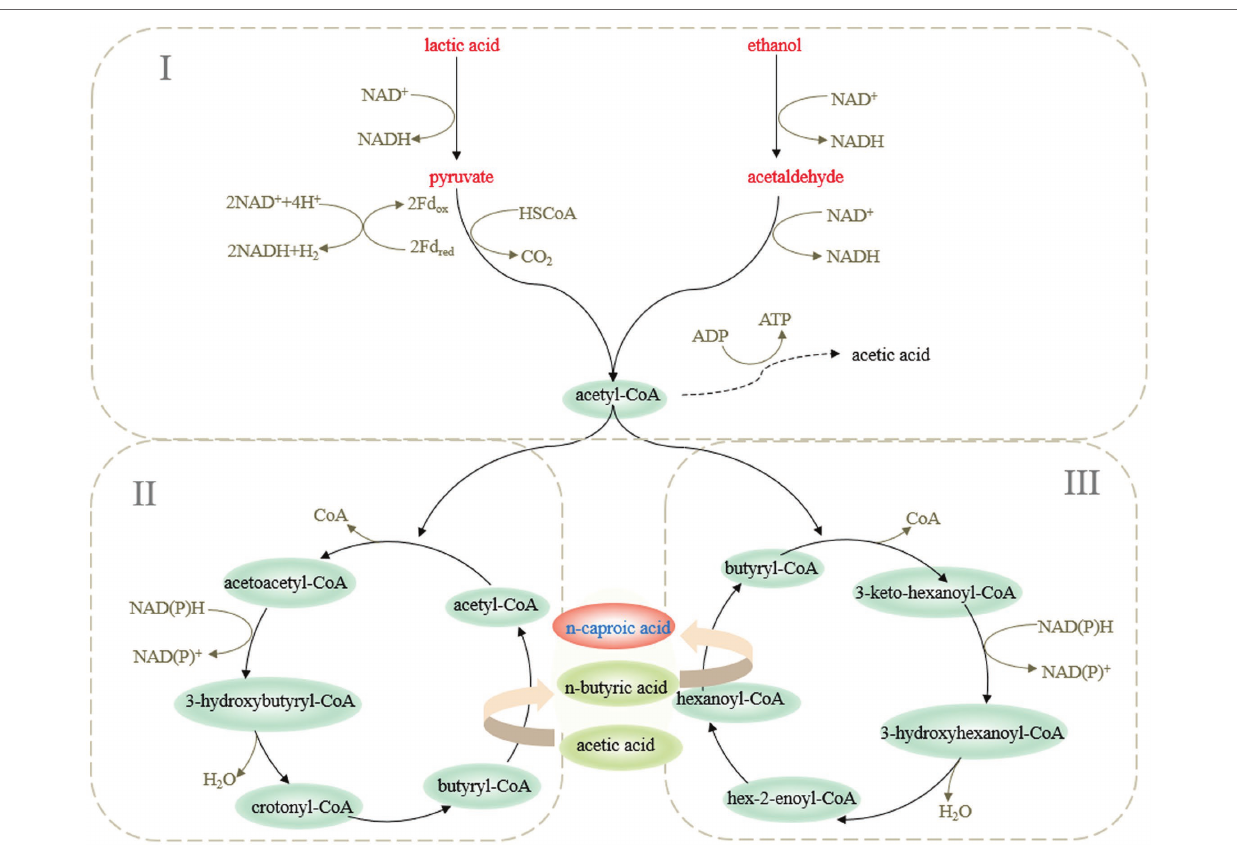
FIGURE 1 | Metabolic pathway of caproic acid production by